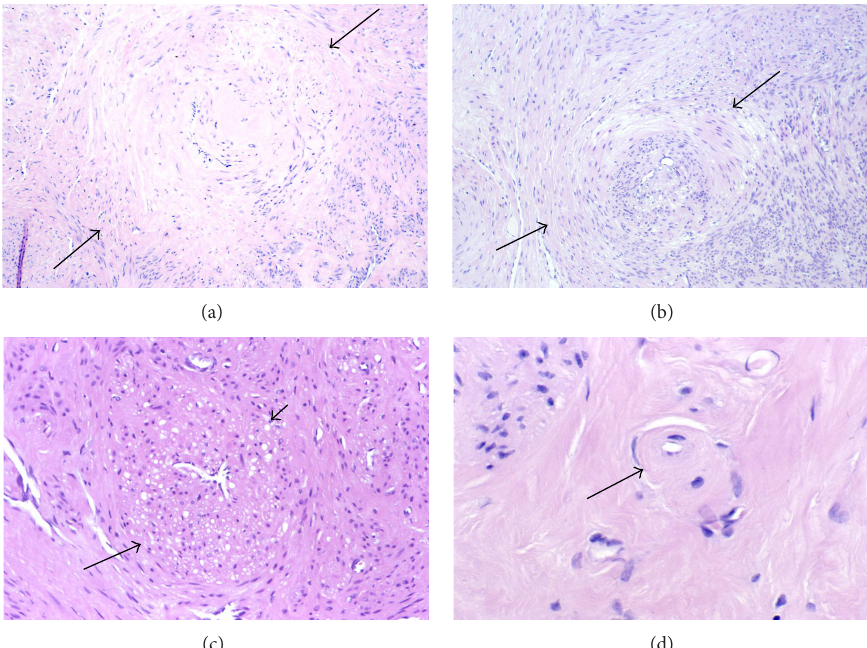
Figure 14: Vascular changes within fibroids mirror those of the fibroid tumor cells. Atrophy of the tumor myocytes occurs as a result of both vascularandinterstitialchanges.Thevascularsmoothmusclecellswithinfibroidtumorsoftenexhibitchangessimilartothoseoccurringinthe tumor myocytes, including hypertrophy and hyperplasia of the medial myocytes (a), medial hyperplasia and intimal fibrosis (b), vacuolization (c),andhyalinization(d).Arrowsmarktheouterperimetersofthethickenedvessels.Notethateachofthesevesselsalsoshowsmarkedstenosis of the lumen, which contributes to the ischemic, atrophic process. Original magnification of (a): 33x, (b): 33x, (c): 66x, and (d):